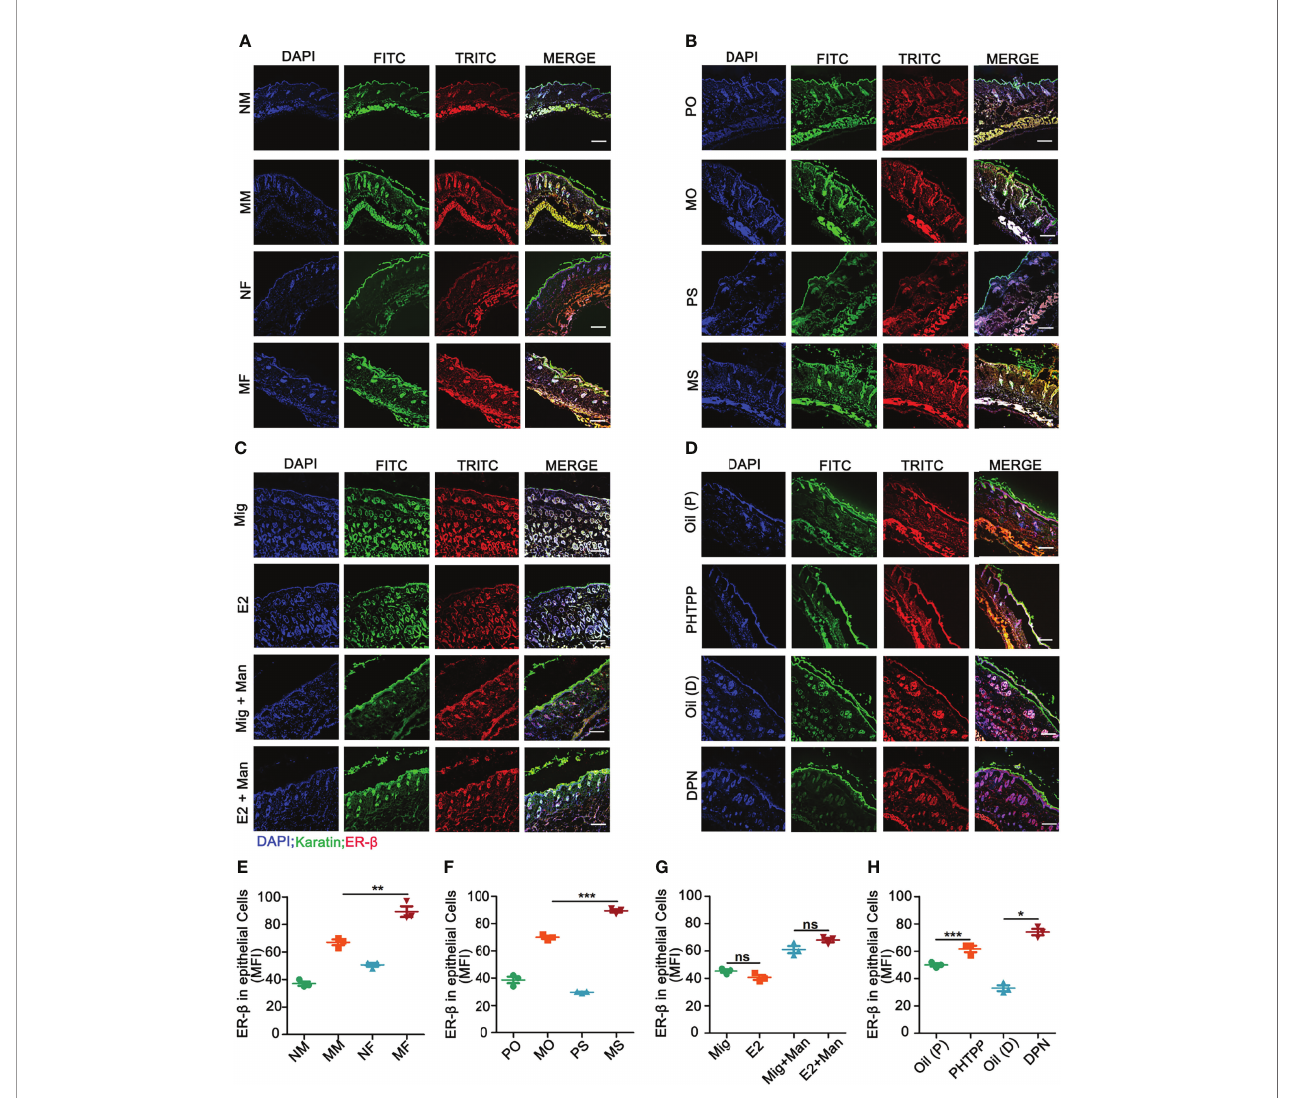
FIGURE 5 | Estrogen increased mannan-induced skin in fl ammation promoted ER- b expression in keratinocytes. (A) Immuno fl uorescence staining of ER- b (red) and keratinocytes (green) in male and female mice with or without mannan application (n = 3/group); Effect of (B) endogenous estrogen, (C) 17- b -estradiol, (D) ER- b antagonist or agonist on ER- b expression in keratinocytes under normal and in fl ammatory conditions (n = 3/group). Scale bar: 200 µm. Nuclei were counterstained with DAPI (blue). (E-H) For quanti fi cation of immuno fl uorescence staining, mean fl uorescence intensity of ER- b stained keratinocytes was calculated using Image J software. Representative pictures are shown. Man, mannan; NM, Naive Male; MM, Man + Male; NF, Naive Female; MF, Man + Female; PO, PBS + OVX; MO, Man + OVX; PS, PBS + Sham; MS, Man + Sham; Mig, miglyol; E2, 17- b -estradiol; Oil (P), E2 + Corn oil + Man; PHTPP, E2 + PHTPP +Man; Oil (D), Corn oil + Man; DPN, DPN + Man. Statistical analyses were performed using an unpaired t test and n indicates number of mice used in each group. The data represent mean ± SEM. ns, not signi fi cant. *p < 0.05; **p < 0.01. ***p <